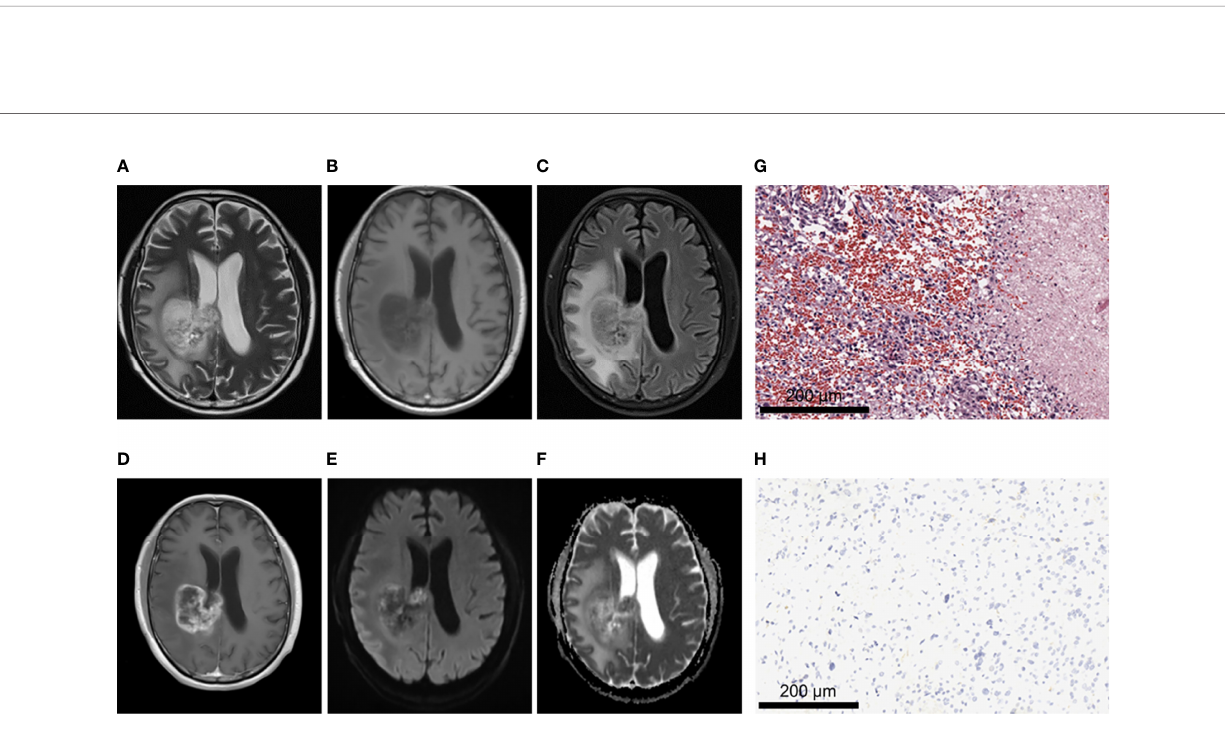
FIGURE 5 | A 62-year-old male patient with glioblastoma of the right fronto-parietal lobe with corpus callosum involvement, WHO grade IV, IDH-wild type. (A – C) MRI axial T2W, T1W, T2-FLAIR sequences showed multiple cystic lesions within the tumor, with uneven signals and severe peritumor edema. (D) T1 postcontrast showed obvious irregular and thick rim enhancement. (E, F) When b value is 1000, tumor was locally obvious restricted diffusion in DWI and ADC images. (G) HE staining showed increased cell density and marked atypia, accompanied by extensive necrosis (×200). (H) IDH1 negative expression (×200).